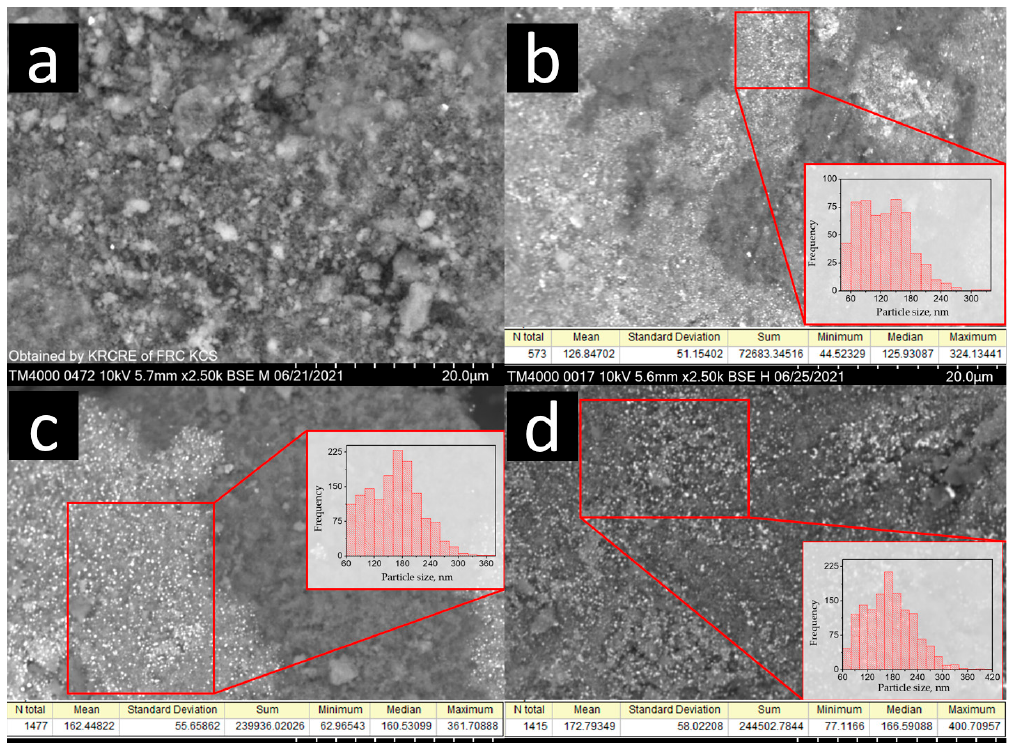
Figure 2. Microphotographs of ( a ) the S450, ( b ) 5NiS450, ( c ) 10NiS450, and ( d ) 20NiS450 catalysts.